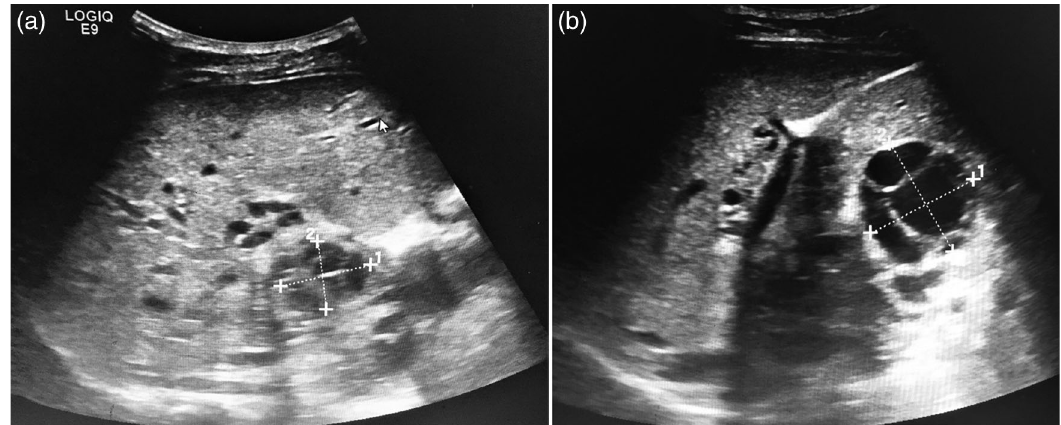
Figure 2. a and b: An abdominal ultrasound showing the presence of multiple multiloculated cystic forma- tions evoking hydatic cysts type CE2 of the WHO classification of segments I, IV, and V.